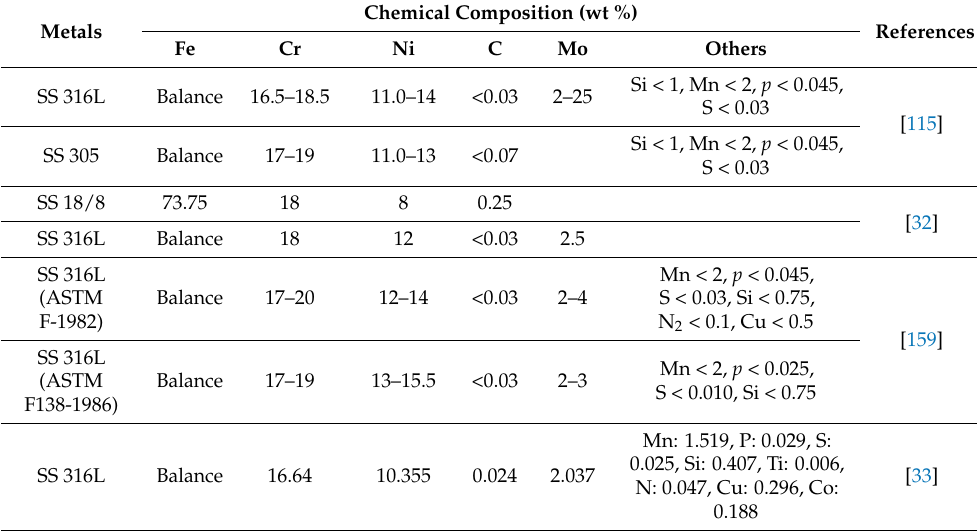
Table 5. Chemical composition of stainless-steel alloys commonly used for analysis.